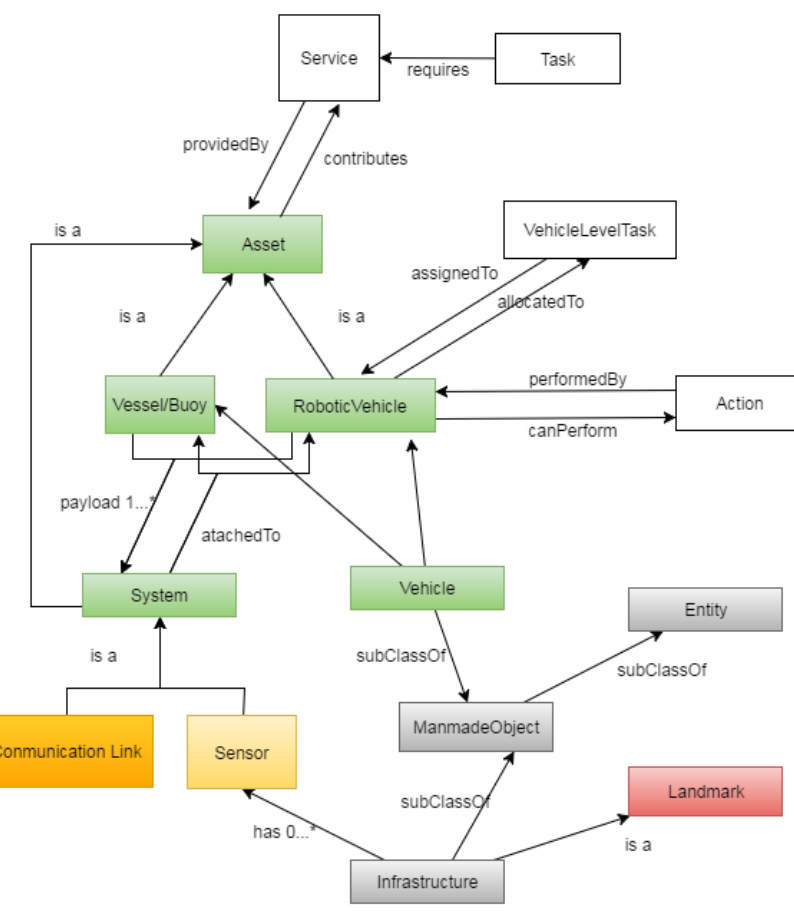
Figure 3. A representation of the overall structure of the core ontology.